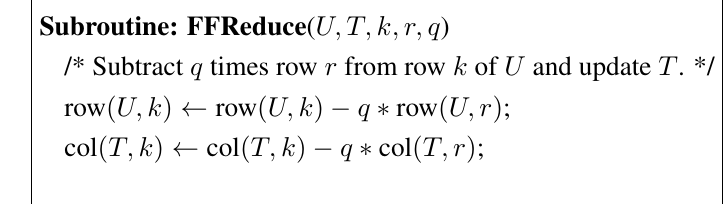
Figure 6. Fraction Free Subtract Subroutine.